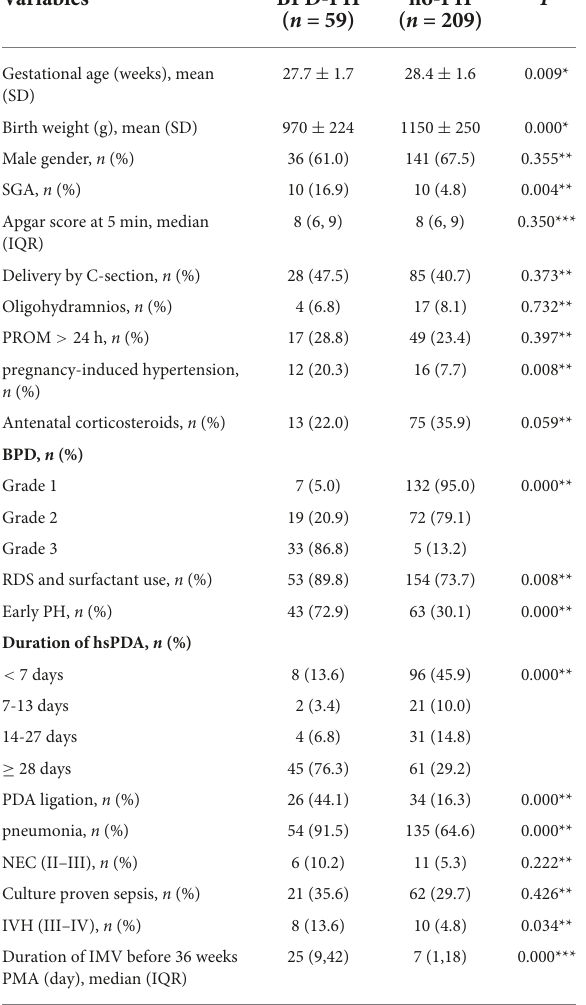
TABLE 1 Maternal and neonatal characteristics between two groups. TABLE 2 The multivariate logistic regression analysis to estimate risk for